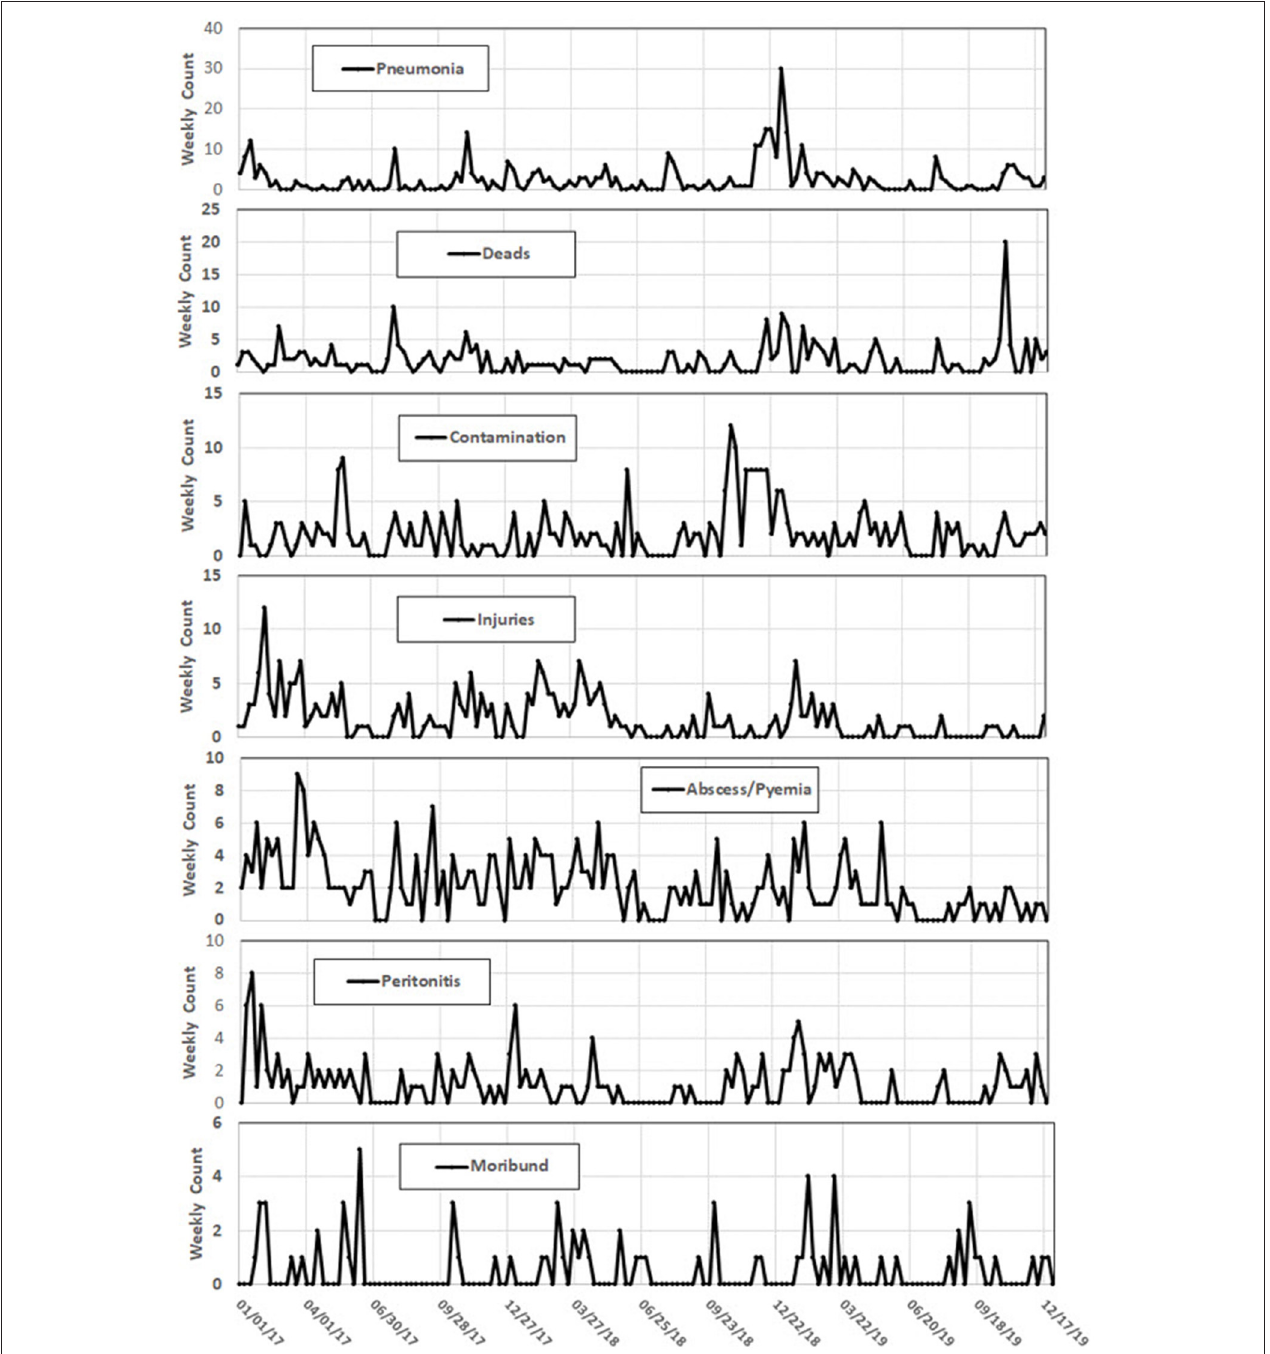
FIGURE 5 | Weekly count plots of common reasons for feral swine slaughter condemnation,